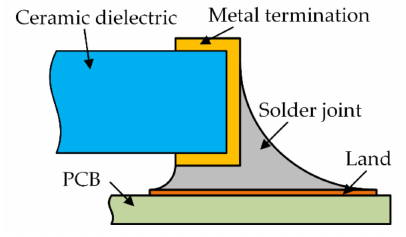
Figure 4. SMT solder joint structure sketch.